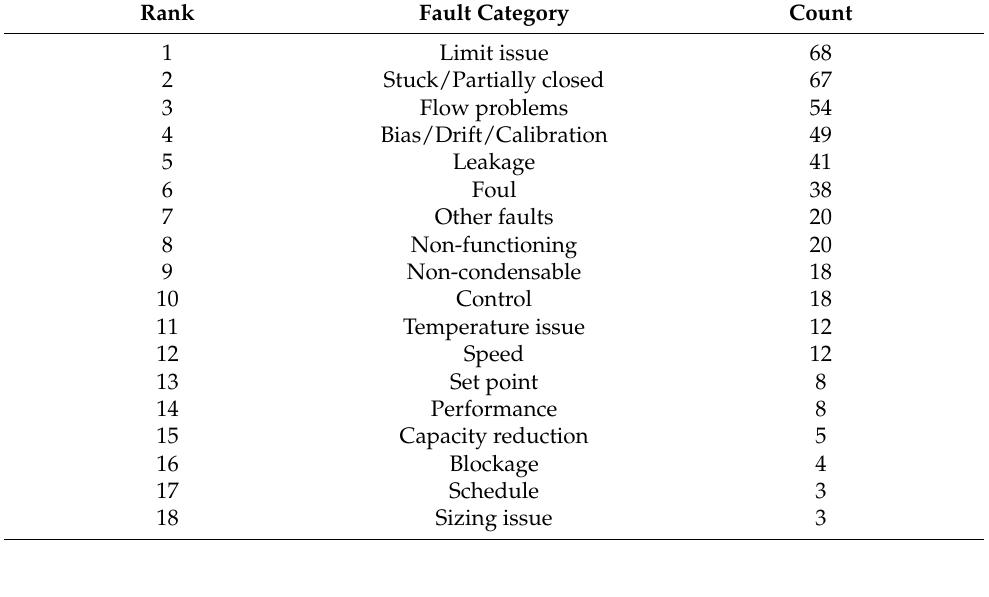
Table 1. Category of faults identified for data-driven techniques.